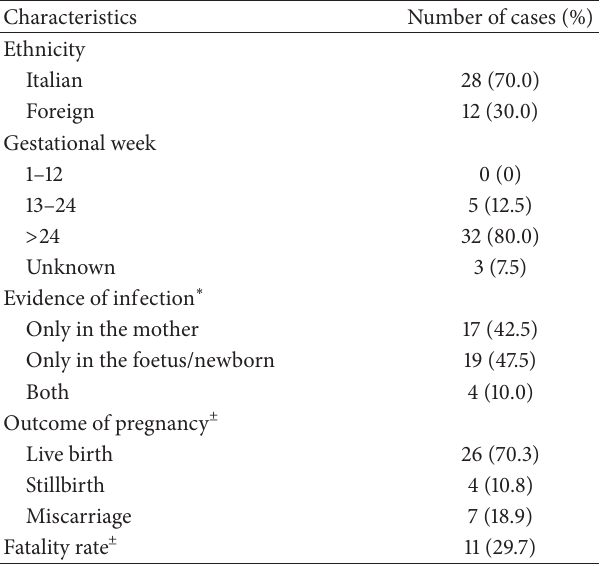
Table 1: Demographic and clinical data of the 40 pregnancy-related listeriosis observed in Lombardy, Italy from 2005 to 2014.